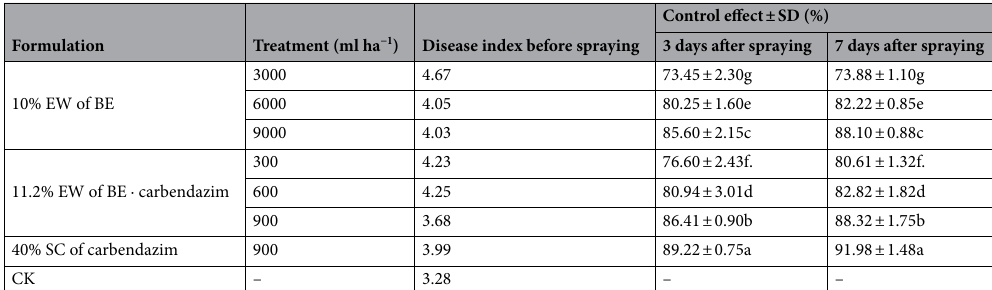
Table 5. Field test of 10% EW of BE control pepper phytophthora blight. Different letters indicate significant differences according to Tukey HSD test comparisons ( p < 0.05).